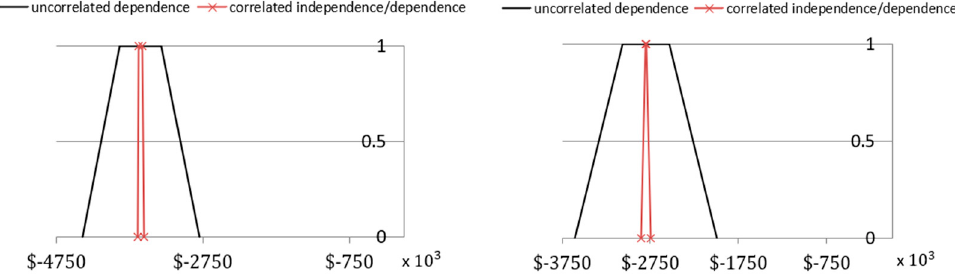
Figure 6. Dependence recognised with the difference of B and A ( Left ) and C and A ( Right